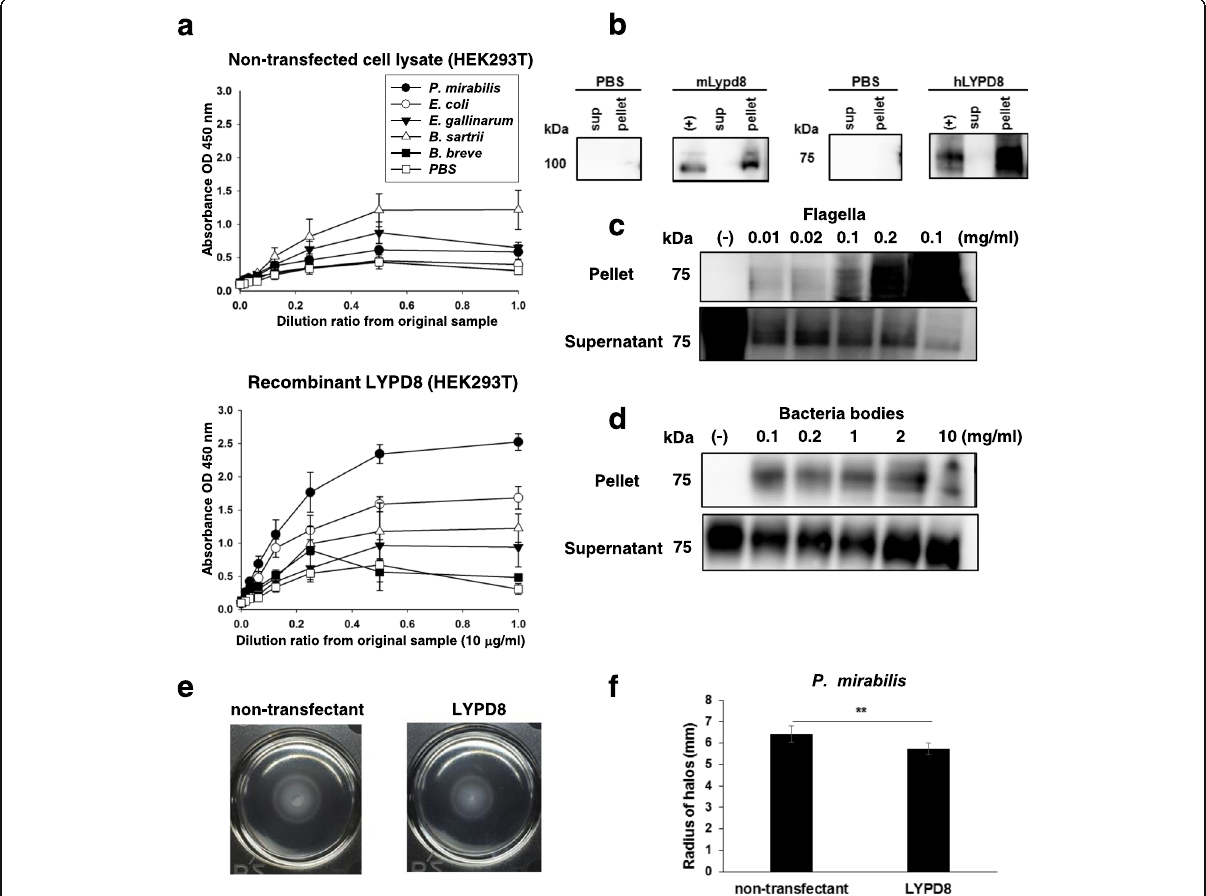
Fig. 2 Function of the hLYPD8 protein generated by a mammalian cell expression system. a ELISA assay for hLYPD8 binding to intestinal bacteria. The quantified bacteria were coated onto microtiter plates and incubated with a dilution series of purified FLAG-tagged hLYPD8 (lower) or control sample (purified sample of non-transfected HEK293T cell lysate) (upper). b – d Immunoblot analysis with the anti-FLAG antibody for the supernatant and pellet of the mixture of FLAG-tagged mLypd8 or hLYPD8 and flagella from P. mirabilis ( b ) and the mixture of hLYPD8 and a gradient dose of flagella ( c ) or bacterial bodies ( d ) from P. mirabilis . e, f Motility of P. mirabilis in semisolid agar with the hLYPD8 protein or a control sample (a purified sample of non-transfected HEK293T cell lysate). Representative photos were shown ( e ). The radii of motility halos were measured at 4 h ( f ). Data are mean ± s.d. ( n = 6 per group). ** p <